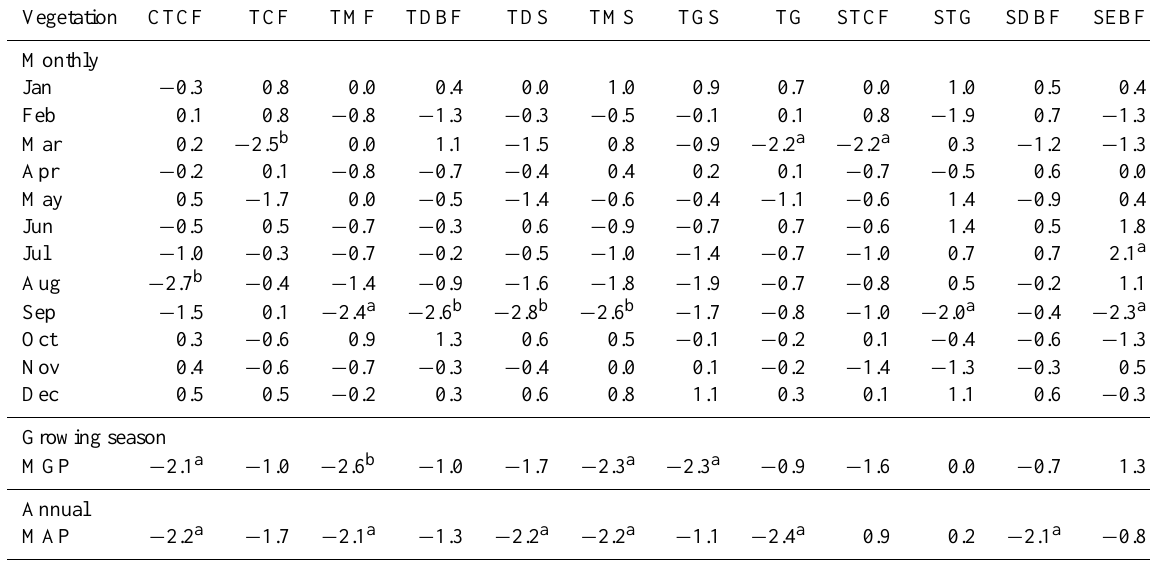
Table 3. Seasonal Mann–Kendall (SMK) trend tests of precipitation by vegetation type from 1982 to 2006. Vegetation